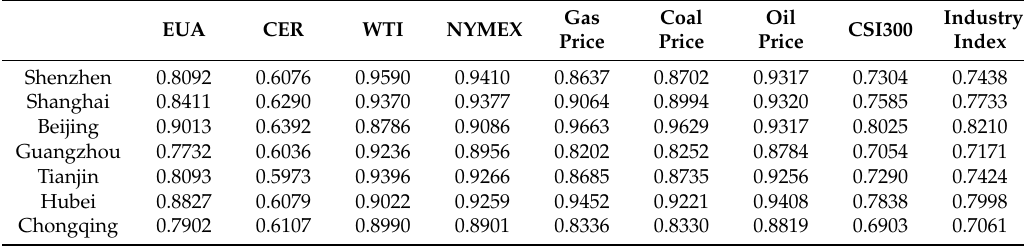
Table 5. Estimated degree of correlation in Deng’s grey relational model.